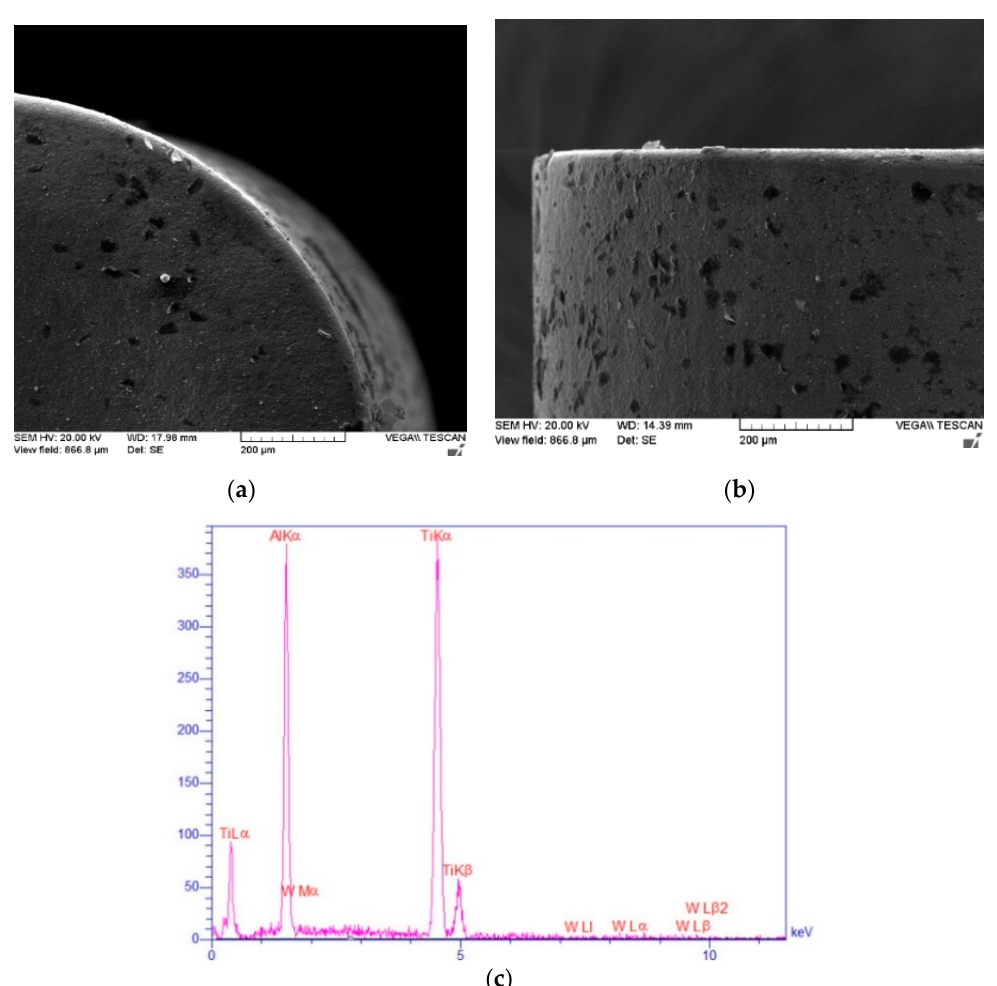
Figure 2. SEM images of the: ( a ) rake side; ( b ) flank side; ( c ) EDX analysis of the flank side of unused insert TS2500 (wt.%). Contribution of elemental compositions wt.% of the flank side with largest contributions of Al = 22.4% and Ti = 77.5%